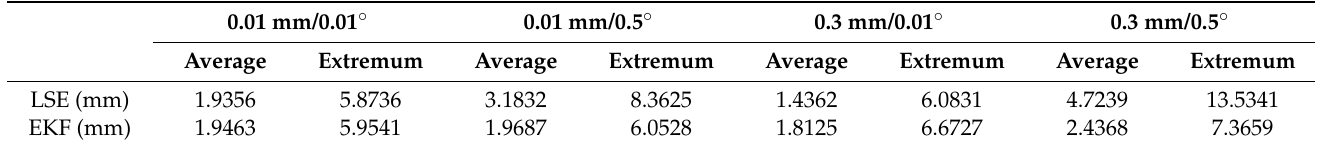
Table 5. The position error after